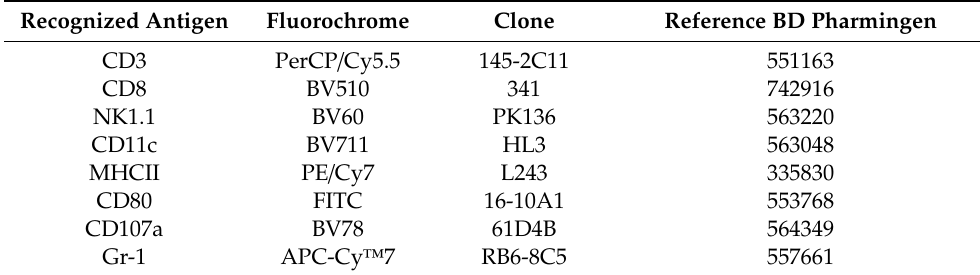
Table 1. List of antibodies used for immune cells identification.